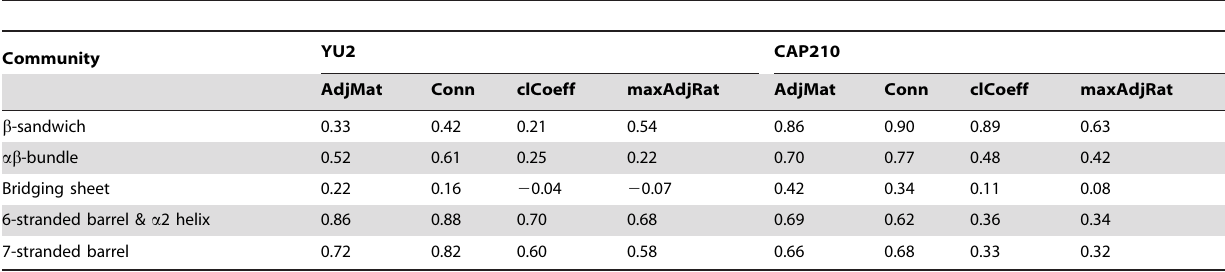
Table 3. Comparison of the YU2 and CAP210 networks to the HXB2 network based on the subdomains in the protein.